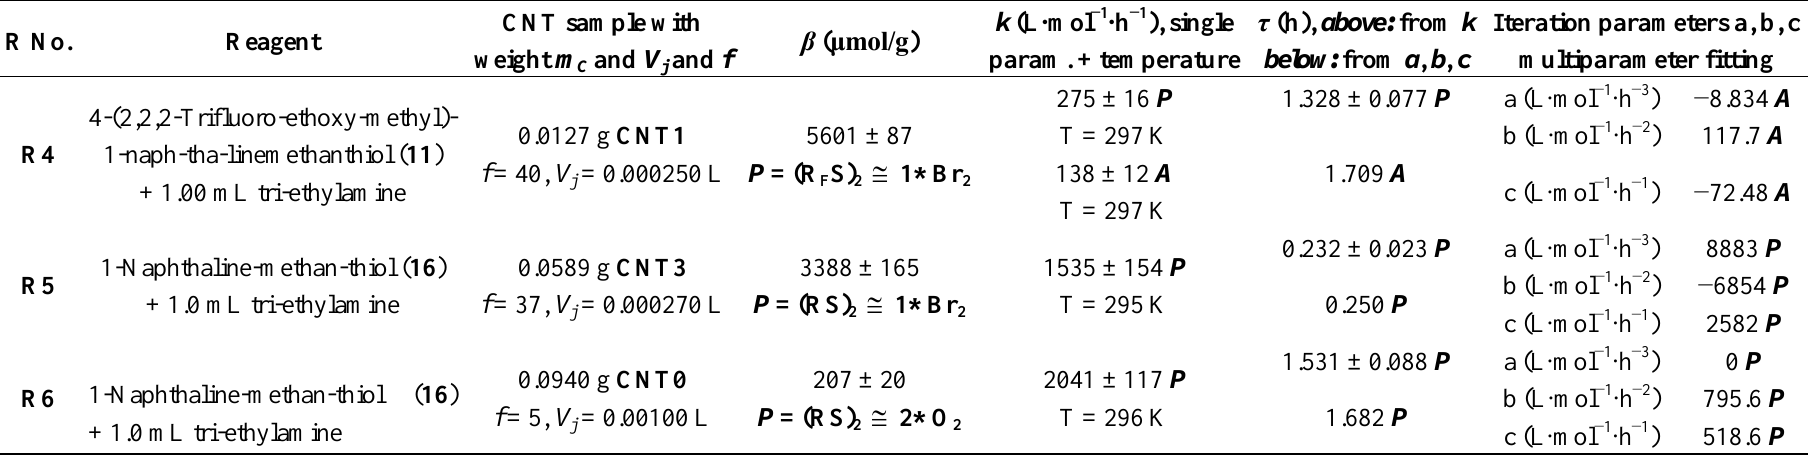
CNT sample with